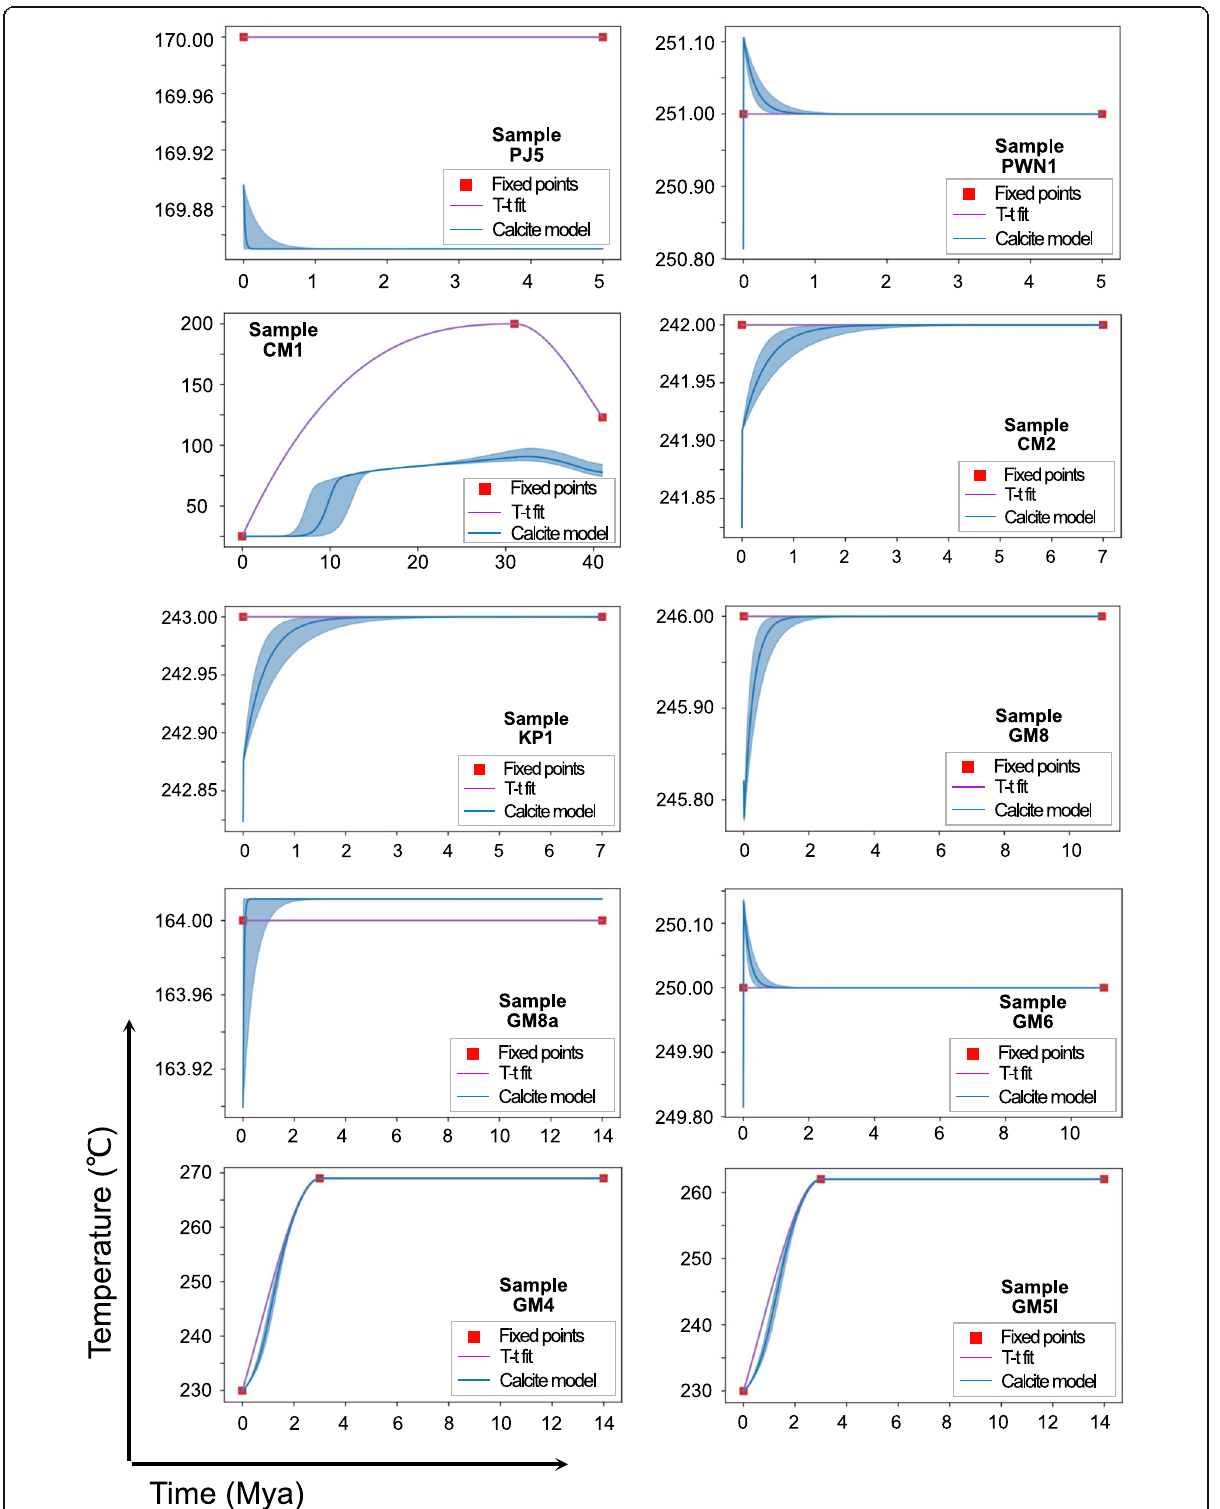
Fig. 5 THRMs (thermal history reordering models) obtained for each sample are shown here. The sample numbers are mentioned in each of the plots. The blue shaded region in each of the plots show the standard error for each generated model, while temperature obtained from clumped isotope thermometry are shown as fixed points and a best fit line is drawn. For additional temperature details, see Supplementary Table